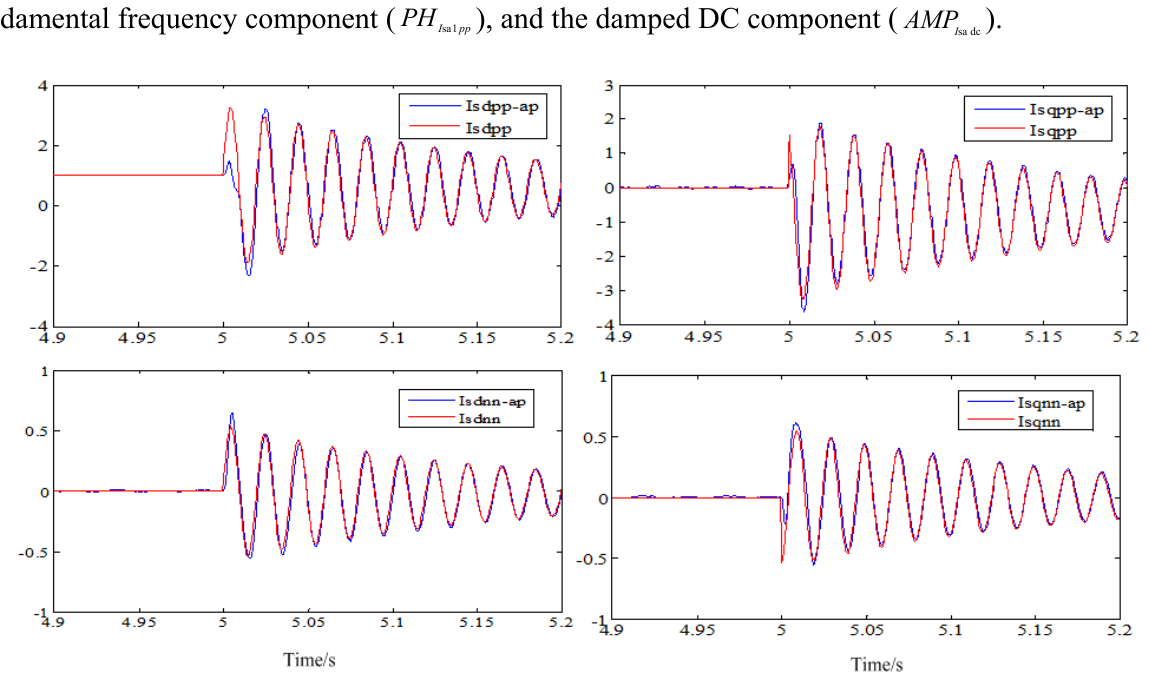
Figure 8. d -axis and q -axis components of the stator current in the ( dq ) + and ( dq ) − reference